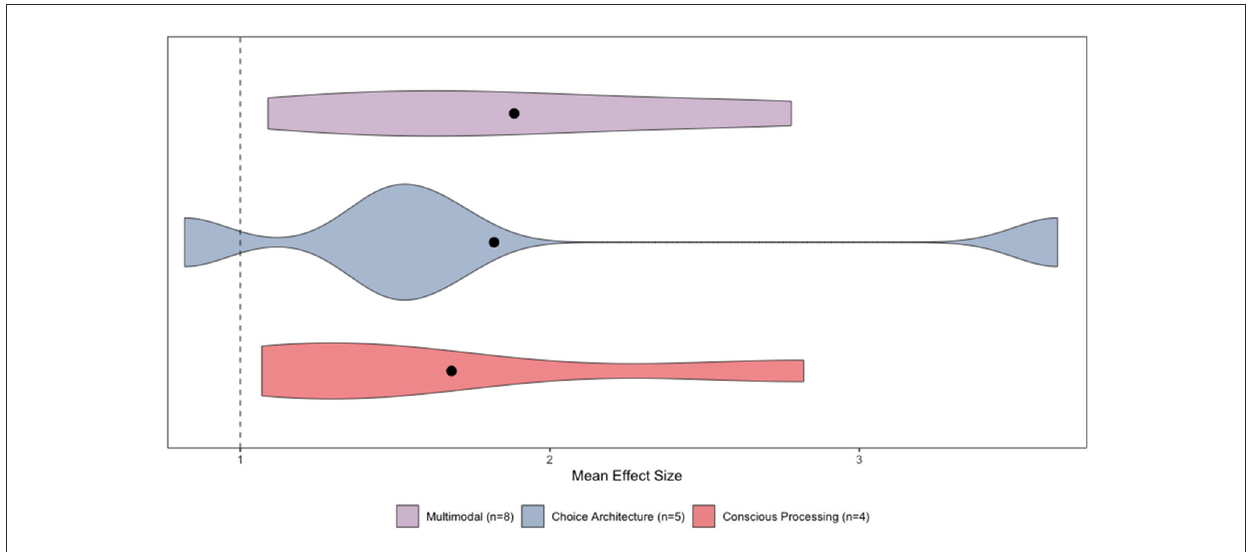
FIGURE7 Violin plot comparing the effect size distributions of the three investigated approaches. Compared to the other two approaches, multimodal interventions had a greater overall effect on meat consumption.